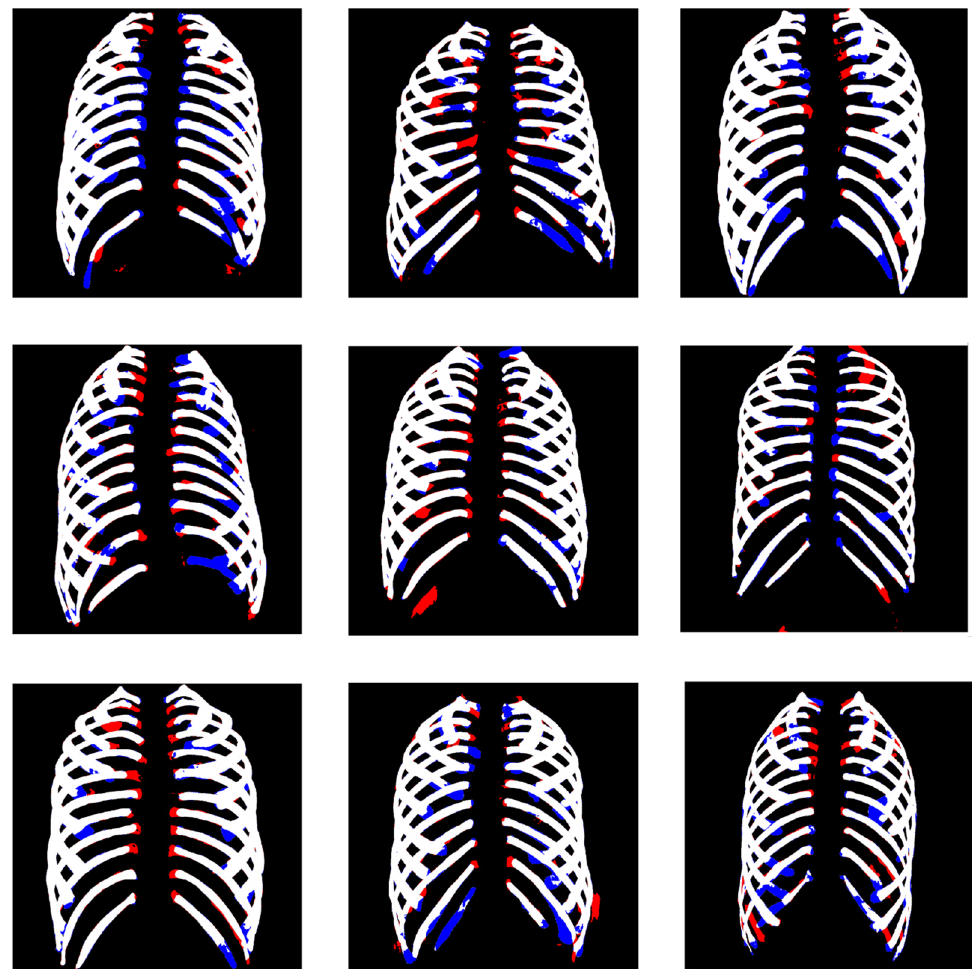
Figure 7. Segmentation predicted result images along with the false positives (FP: red color) and false negatives (FN: blue color).